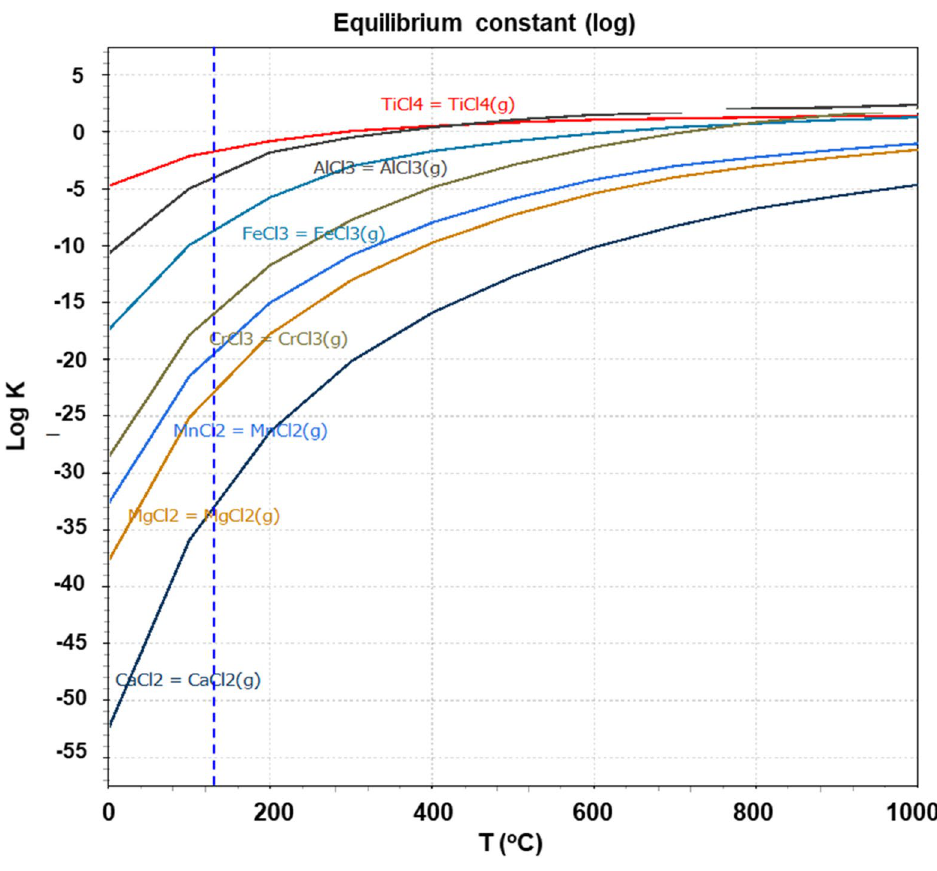
Figure 5. Calculation results of the vapor pressure of TiCl 4 and residual chloride.